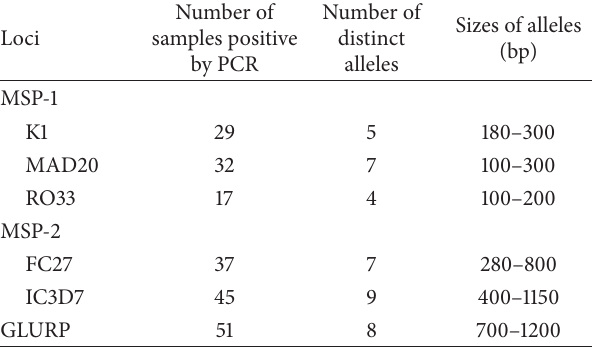
Table 3: Summary of all the isolates positive for each allelic family for msp1 , msp2 , and glurp along with the number of alleles and the range of sizes of alleles.